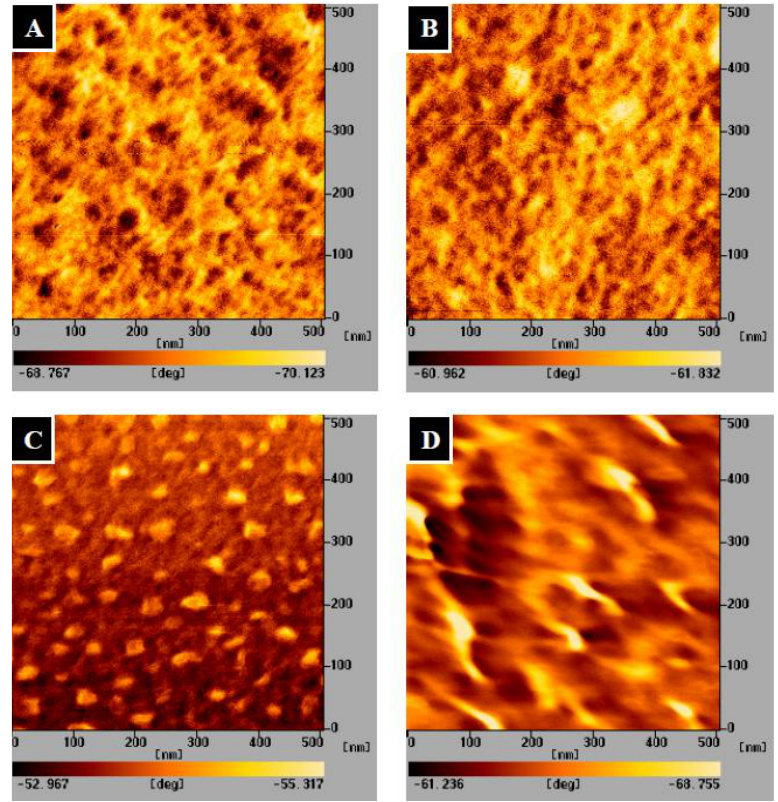
Figure 3. AFM images of ( A ) chitosan ( B ) gelatin ( C ) CG hybrid ( D ) TPP-CG